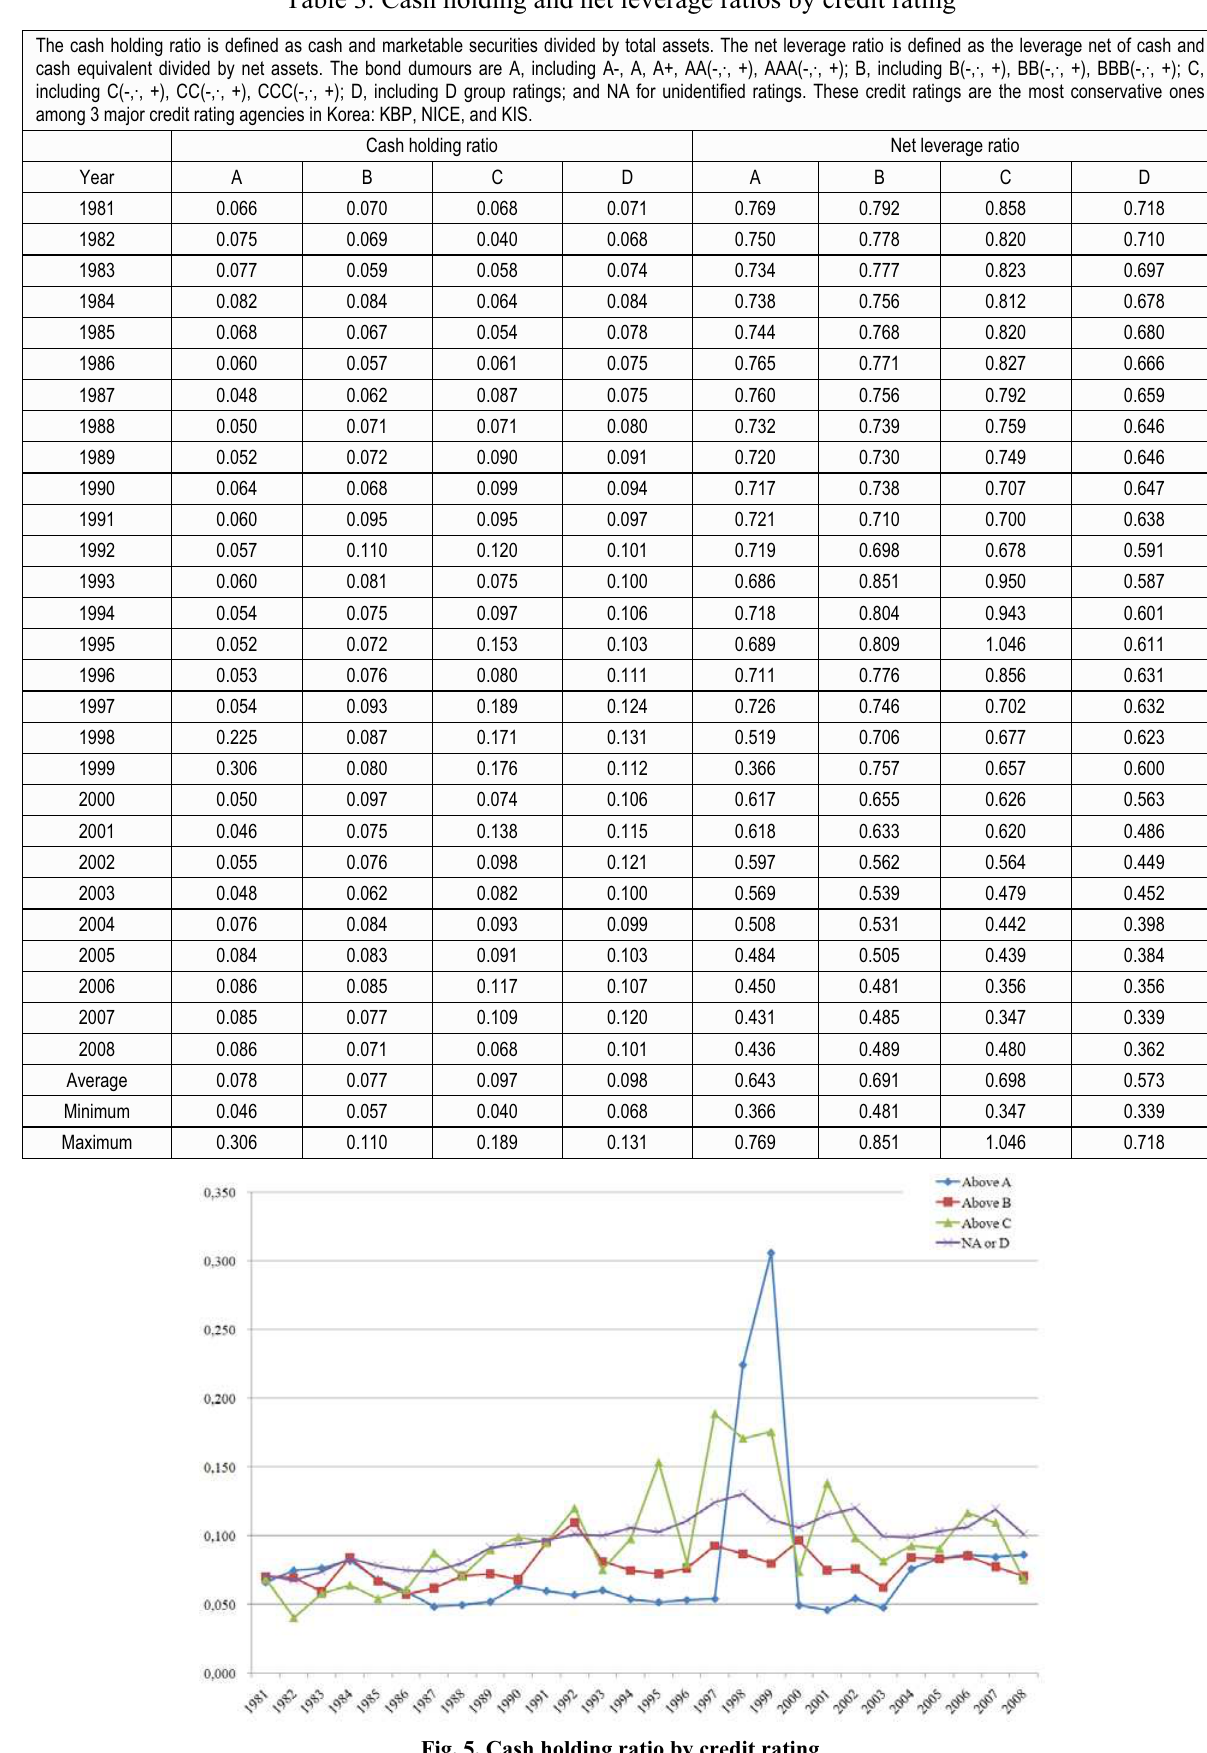
Fig. 5. Cash holding ratio by credit